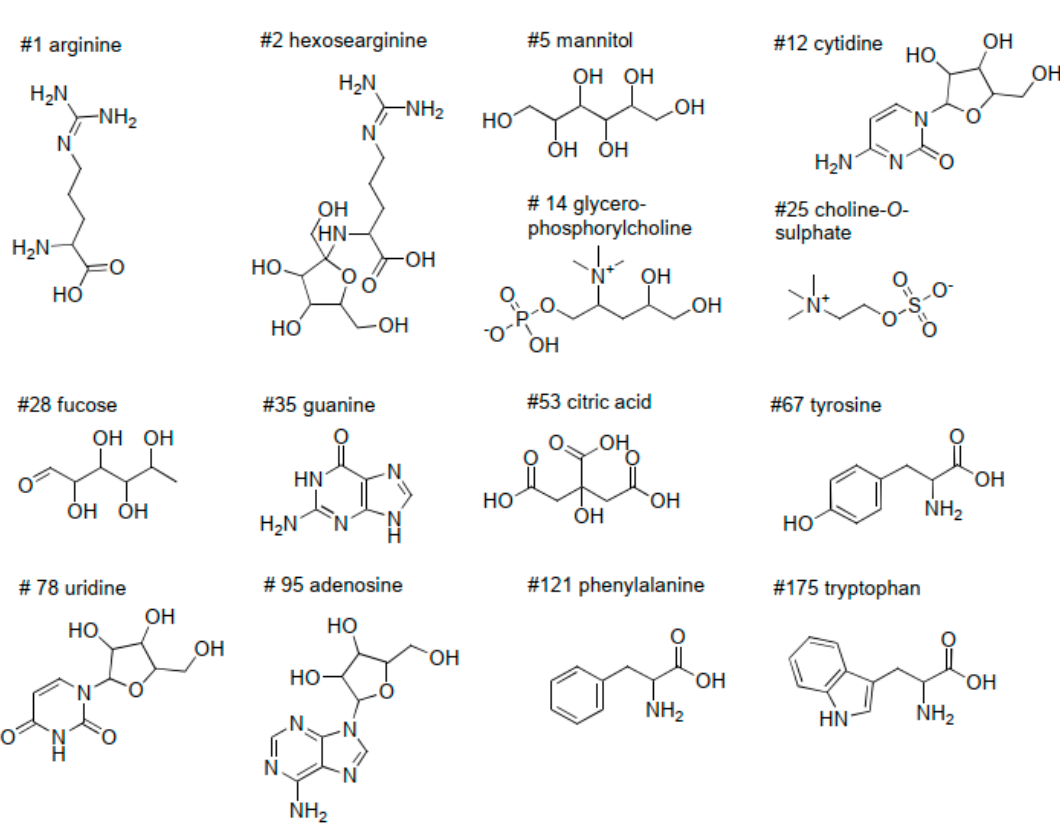
Figure 2. Structures of some of the identified compounds with #ID from Table 2.